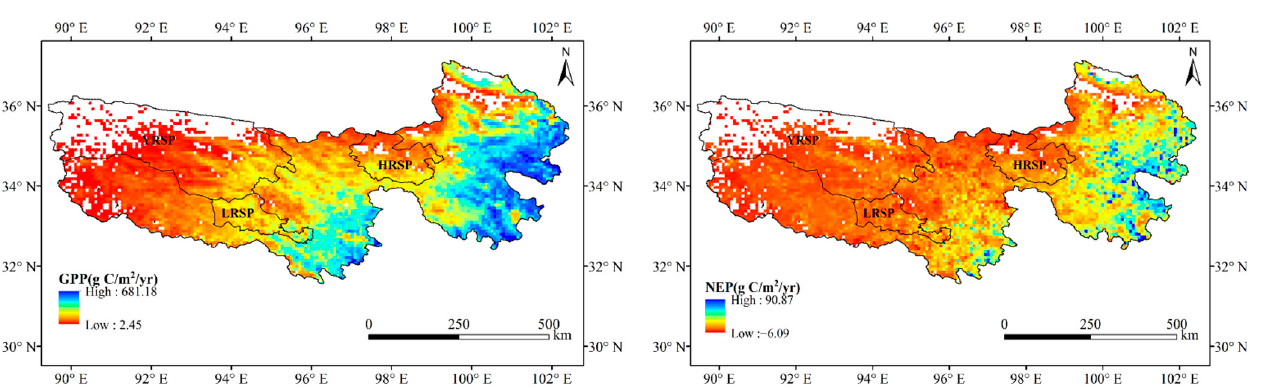
from 1985 to Figure 5. The spatial distribution variation in the average annual GPP ( a ) and NEP ( b ) over the TRSR from 1985 to 2018.